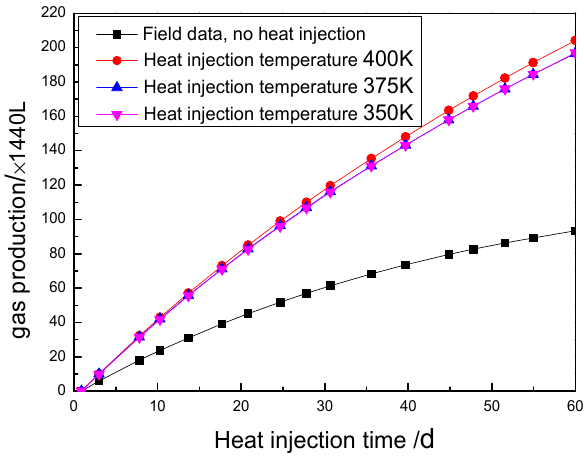
Figure 4. E ff ect of heat injection temperature on total gas Figure 4. Effect of heat injection temperature on total gas production.